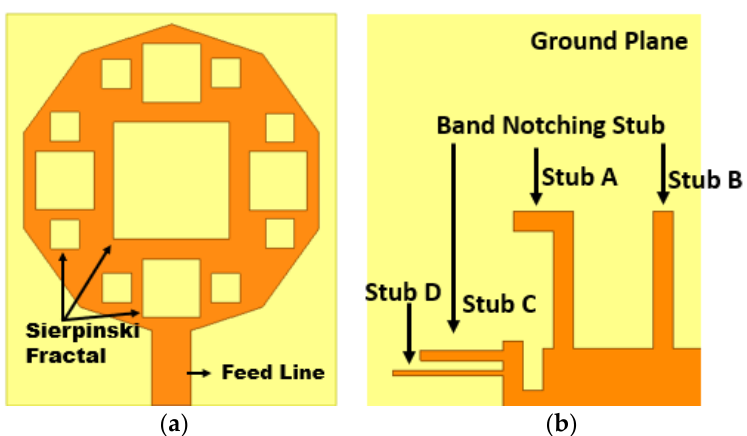
Figure 12. Front ( a ) and rear ( b ) view of Decagonal Sierpinski fractal antenna.